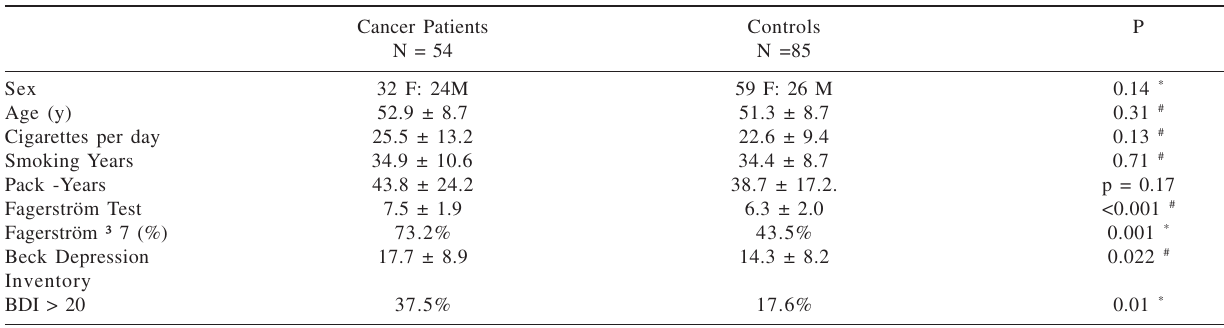
Table 2 - Univariate analysis of demographics, tobacco consumption, Fagerströn Tolerance Questionnaire and Beck Depression Inventory between cancer patients and matched